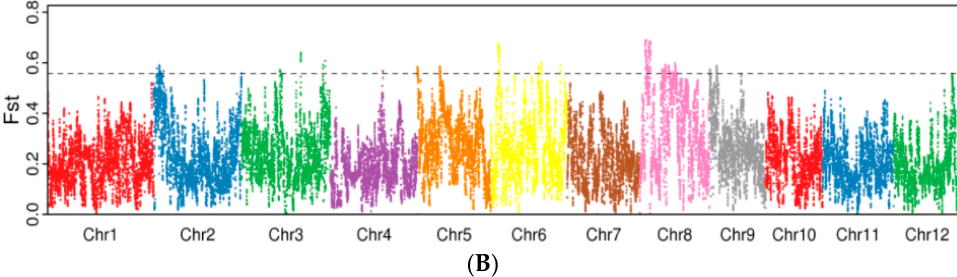
Figure 9. The whole genome (100 kb window, 10 K step) distribution of the genetic differentiation index (Fst) between the two subpopulations of DXWR. ( A ) The natural logarithms of the probability data [LnP(K)] and Δ K; ( B ) the dotted line represents 99% confidence region of Fst distribution. The 31 highly differentiated regions have 1233 genes, including three drought re- sistance genes ( OsPP18 [18], OsCYP20-2 [19], and OsTF1L [20]) . In addition, the highly differentiated region at Chr2 1400001-1500000 coincided with the follow-up quantitative trait locus (QTL) region for drought avoidance in DXWR, and the highly differentiated